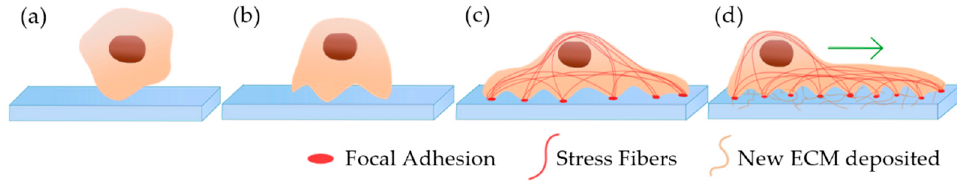
Figure 5. The cell adhesion process on scaffold surface. ( a ) The cell comes in contact with scaffold surface and loosely attaches onto the substrate, ( b ) the cell starts to flatten, ( c ) the cell spread its membrane and form focal adhesions that connect the cell securely on the scaffold surface with intracellular actin filaments (stress fibers) through integrin, and ( d ) the cell begins to migrate to the scaffold surface generating new EMC (the green arrow indicates migration direction).